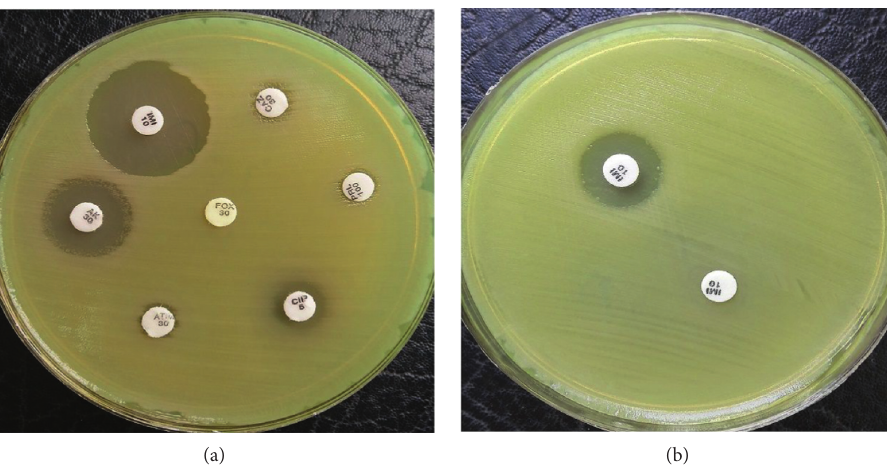
Figure 1: Evaluations of antibiotic resistance pattern and AmpC and MBL producing strains by disk diffusion method. (a) Resistant to cefoxitin (FOX) disk indicates AmpC producing strain. (b) The MBL producing isolates were considered positive when the zone diameter difference between imipenem+EDTA and imipenem discs was more extensive than 7mm.